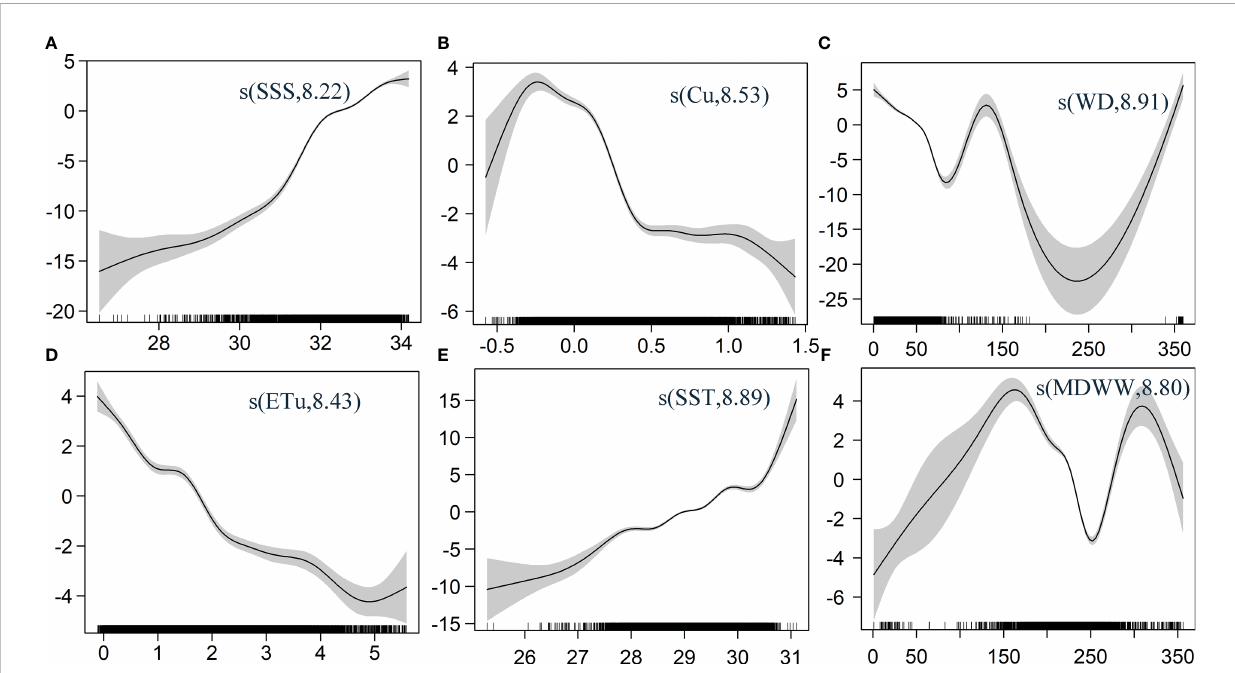
FIGURE 6 Response curves of SDD to changes in (A) SSS, (B) Cu, (C) WD, (D) ETu, (E) SST and (F) MDWW. The Y-axis in each subplot represents the smoothing function term for each factor, and the numbers in brackets represent degrees of